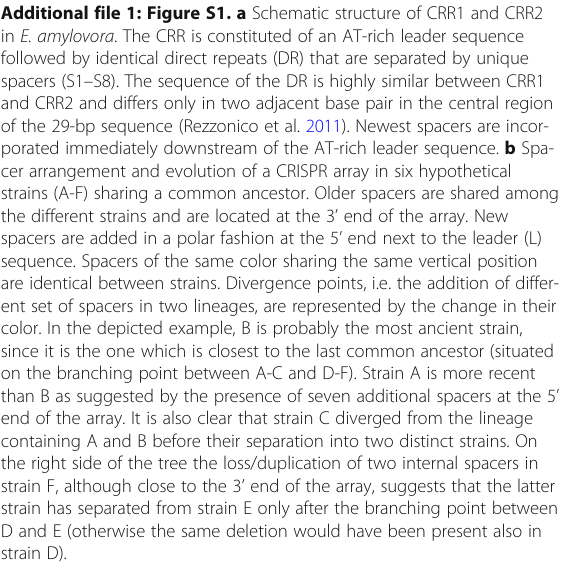
typal genotype. Table S3. Distribution of isolates belonging to the A- derived, D-derived and PCR null genotypes in the countries analyzed in this work. Table S4. Comparison of the VNTR profiles between genome- sequenced isolates displaying the A-derived and the D-derived genotype (Bühlmann et al. 2014). Empty cells indicate missing microsatellite. Additional file 3: Figure S2. Approximate location and CRR1 genotype of E. amylovora isolates in the region spanning from Eastern Europe to Central Asia. Two main areas of influence are recognizable, with the A- derived genotype radiating from the region surrounding Black and